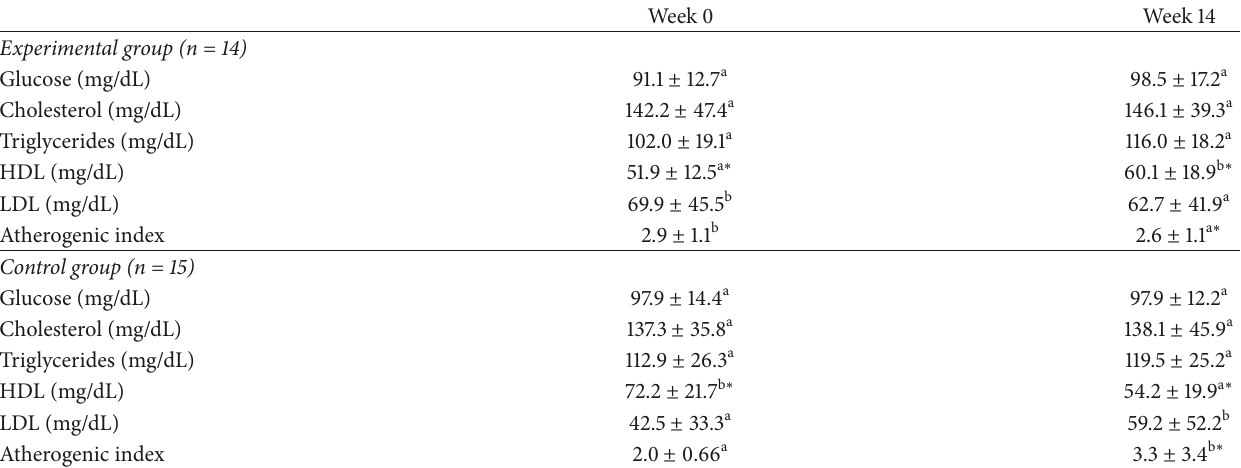
Table 2: Biochemical parameters of experimental and control